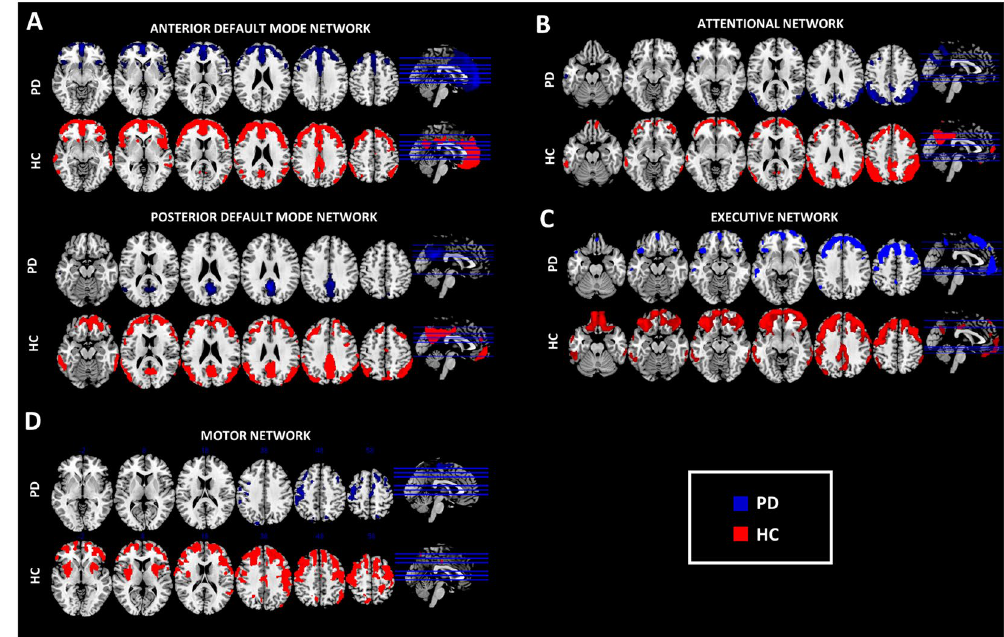
posterior default mode network; ( B ) attentional, ( C ) executive networks, ( D ) motor network. A connectivity derangement is present in all the resting-state systems, particularly in the frontal components of each network. Resting-state networks were obtained using seed-based intercorrelation analysis. Clusters with a minimum spatial extent of 50 voxels are shown, with a voxel-wise significant threshold of p < 0.01